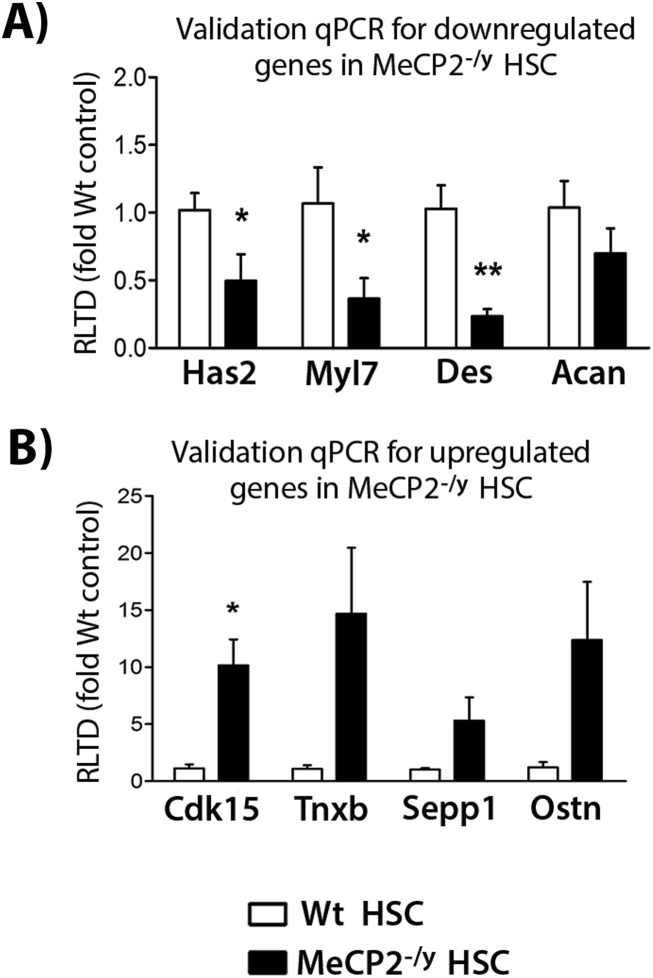
(A) mRNA levels of Has2, Myl7, desmin (Des), and aggrecan (Acan) as down-regulated genes and (B) Cdk15, Tnxb, Sepp1, and Osnt as up-regulated genes were quantified by qRT-PCR to validate the results of microarray. Error bars in relevant panels represent mean ± SEM. Statistical significance was determined by Student t test; *P < .05, **P < .01. RLTD, relative level of transcriptional difference.